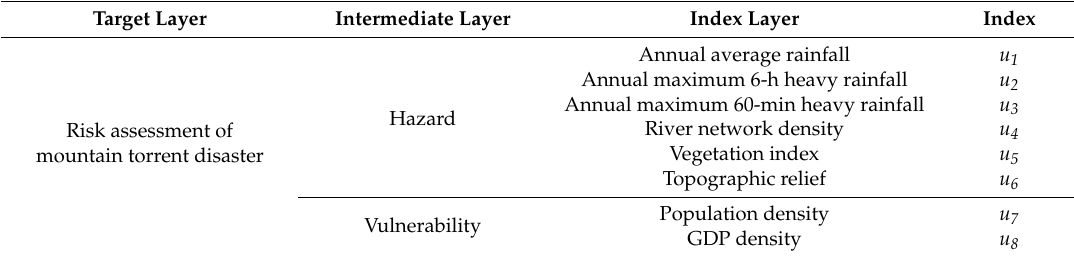
Table 1. Risk index system for mountain torrent disaster